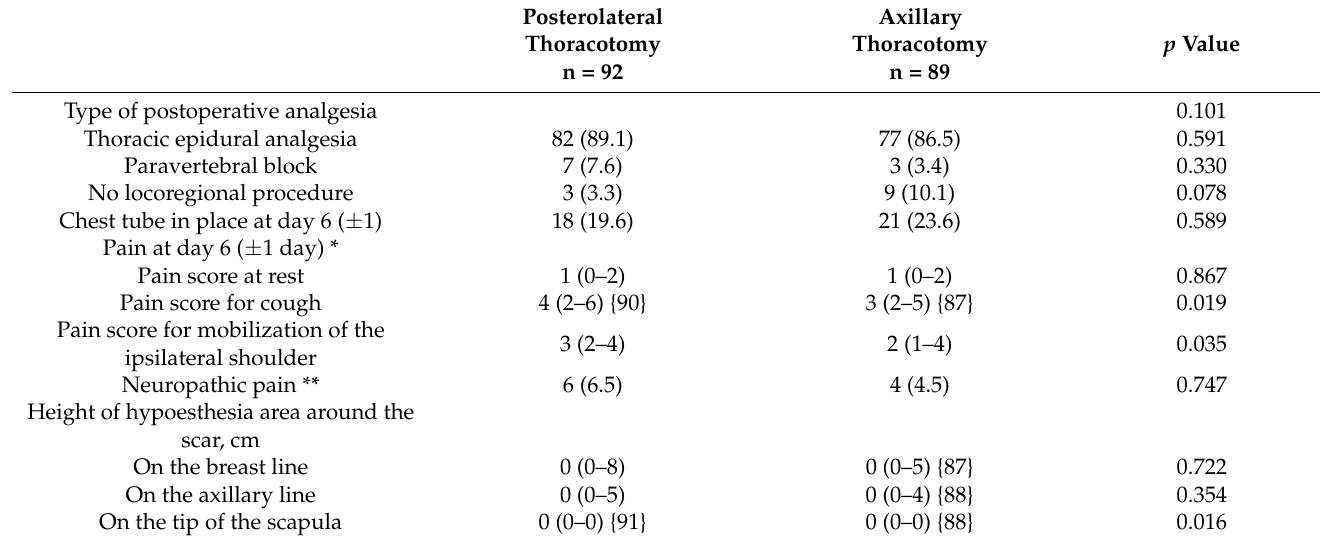
Table 3. Postoperative hospital stay variables in posterolateral and axillary